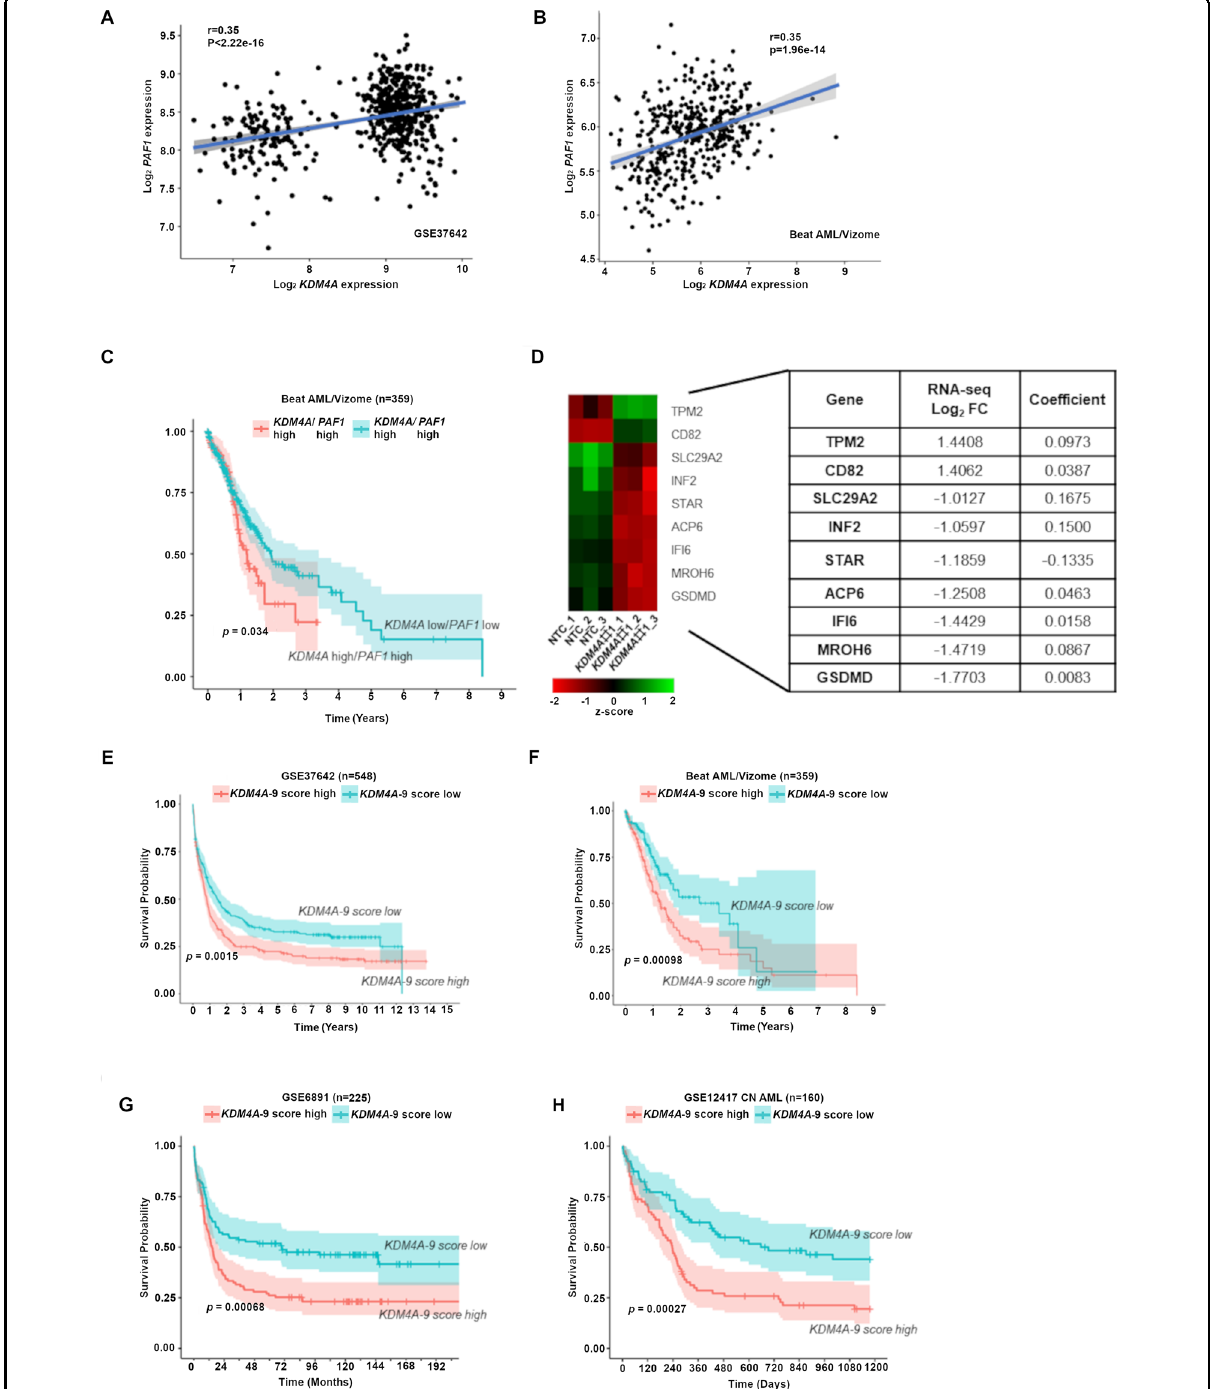
Fig. 6 A core 9-gene signature downstream of KDM4A strongly associated with clinical outcome. A – B Scatterplot showing the correlation between expression of KDM4A versus PAF1 in primary AML patient samples (GSE37642) ( A ) and (Beat AML/Vizome), R by Pearson correlation, p <0.05 ( B ). C Kaplan-Meier survival analysis conducted in Beat AML dataset. Patients with both KDM4A high and PAF1 high expression have inferior overall survival. Patients dichotomized into high and low groups for KDM4A or PAF1 based on whether expression was above the median for each gene; p by log-rank test. D Heatmap showing gene expression of the KDM4A-9 gene signature genes with the table of their respective regression coef fi cients and log 2 FC as determined by RNA-seq in KDM4A KD THP1 cells. E – H Kaplan-Meier survival analysis conducted in the large AML datasets (GSE37642) ( E ), (Beat AML/ Vizome) ( F ), (GSE6891) ( G ), and (GSE12417) ( H ) showing that the KDM4A-9 score can predict survival across AML patients of varying subtypes. Patients were dichotomized into high and low groups based on whether they possessed a score above or below the median signature score; p by log-rank